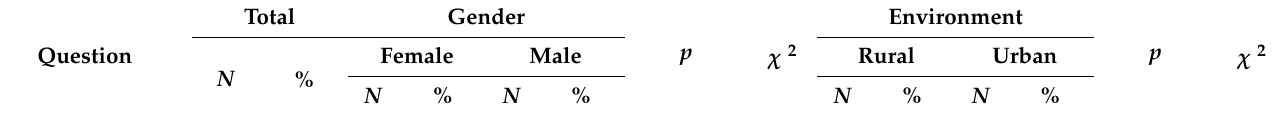
Table 2. Distribution of responses regarding the attitude of subjects toward airborne infection